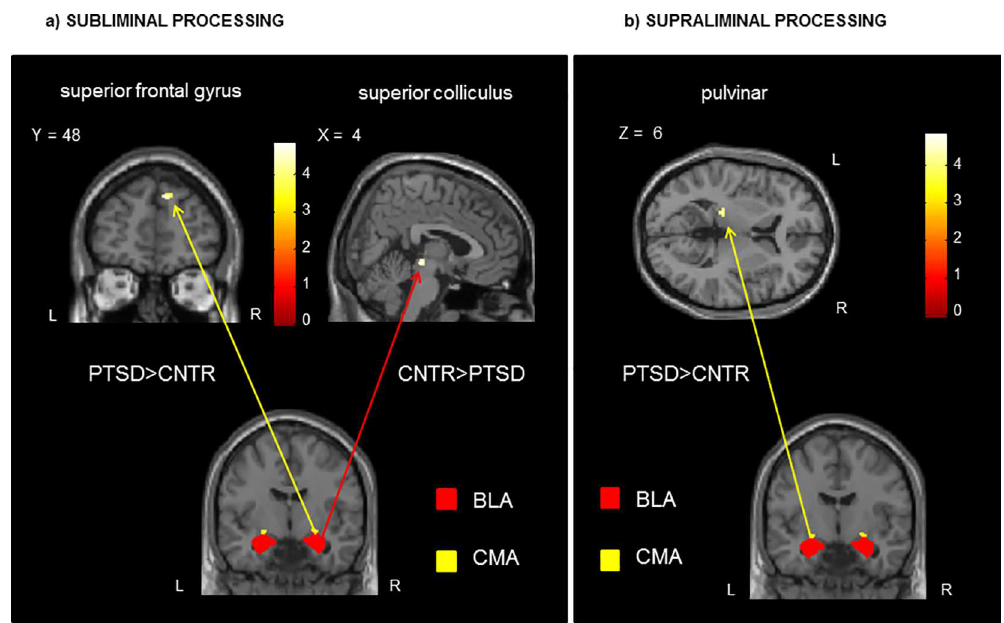
Fig 2. On the left,a) Increased(PTSD > CNTR) and decreased(CNTR > PTSD)functionalconnectivityof the amygdala complexesduringprocessing of SUBLIMINAL (subconscious)trauma-related words in PTSD as comparedto controls.On the right,b) Increased(PTSD > CNTR) functional connectivityof the amygdala complexes duringprocessingof SUPRALIMINAL(conscious)trauma-related words in PTSD as compared to controls.Coordinates are reportedin MNI.Color bar indicates t scores. Note: BLA: basolateralamygdala; CMA: centromedial amygdala; CNTR: control group;L: left; PTSD: post-traumatic stress disordergroup; R: